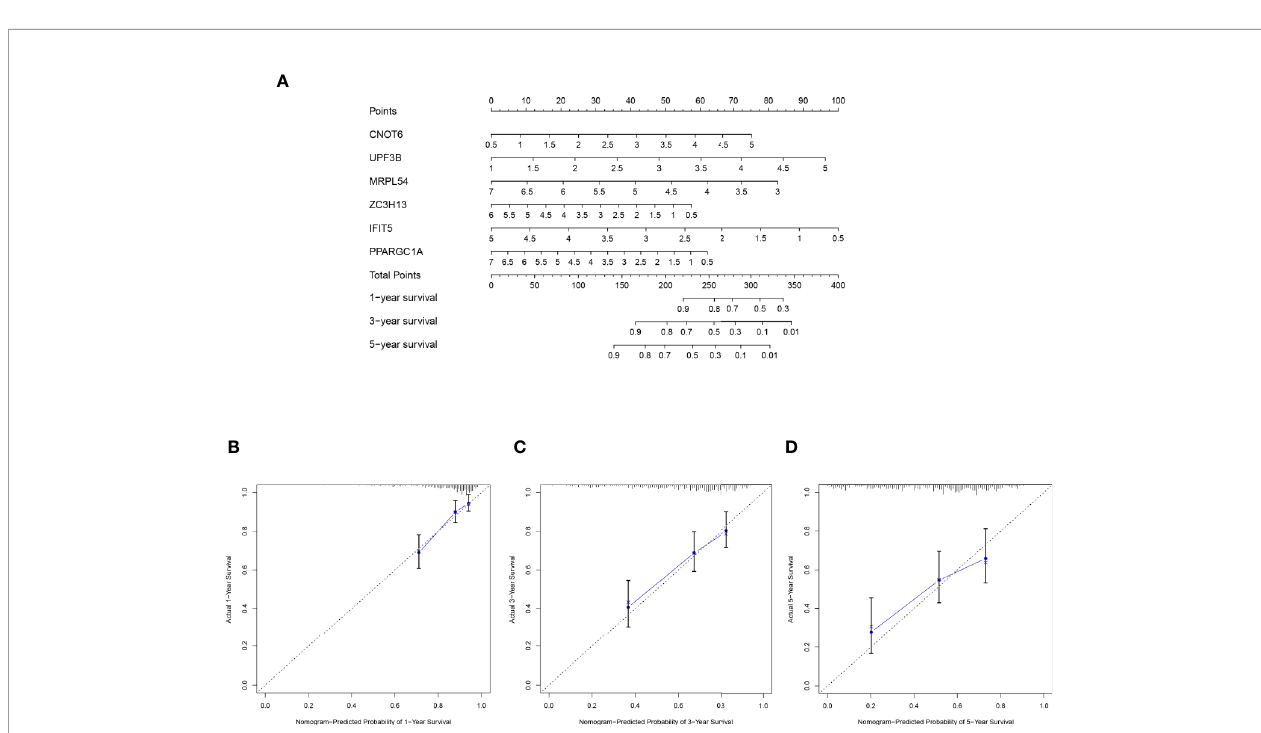
FIGURE 10 | A nomogram in TCGA HCC dataset. (A) The nomogram was built based on this six-RBP gene signature in the training cohort. (B – D) The calibration plots showed good predictive performance for OS at 1-, 3-,